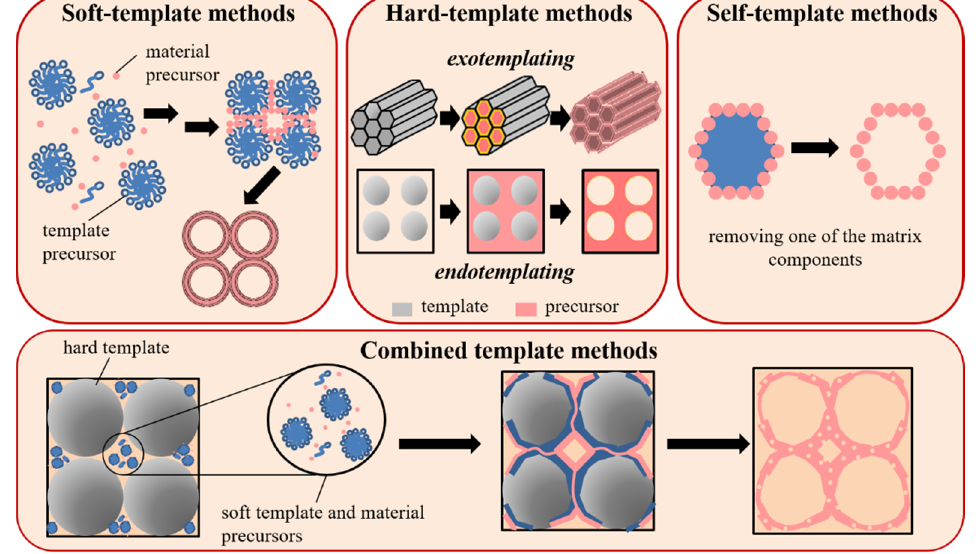
Figure 2. Classification of template synthesis methods by type of artificial template.